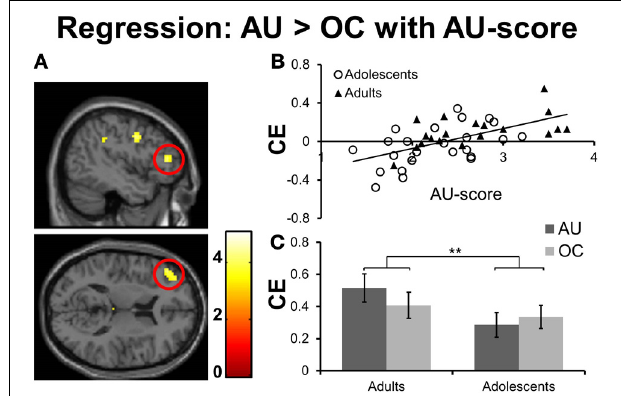
FIGURE 4 | (A) Whole brain results for the regression of AU-score on the contrast AU > OC, thresholded at p < 0 . 001, uncorrected; > 10 contiguous voxels (section coordinates: X = − 45, Z = 12). Color–scale represents t -values. (B) Correlation between creative thinking related activation (AU-OC) for the left IFG/MFG (ROI-peak-value at MNI coordinates − 45, 39, 12) and AU-score for adolescents (open circles) and adults (filled triangles). (C) Contrast estimates for AU and OC conditions relative to baseline for left IFG/MFG. Results for adolescents are presented left, results for adults are presented right. CE, Contrast estimate. ∗∗ p ≤ 0 .